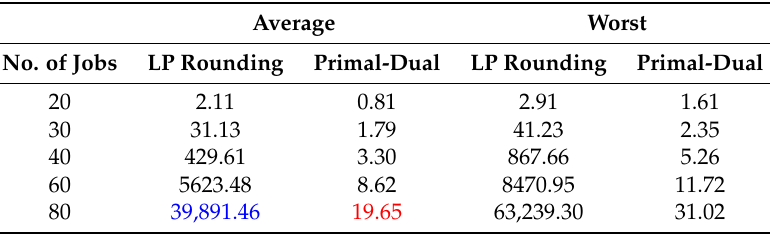
Table 2. The computation time in seconds for the